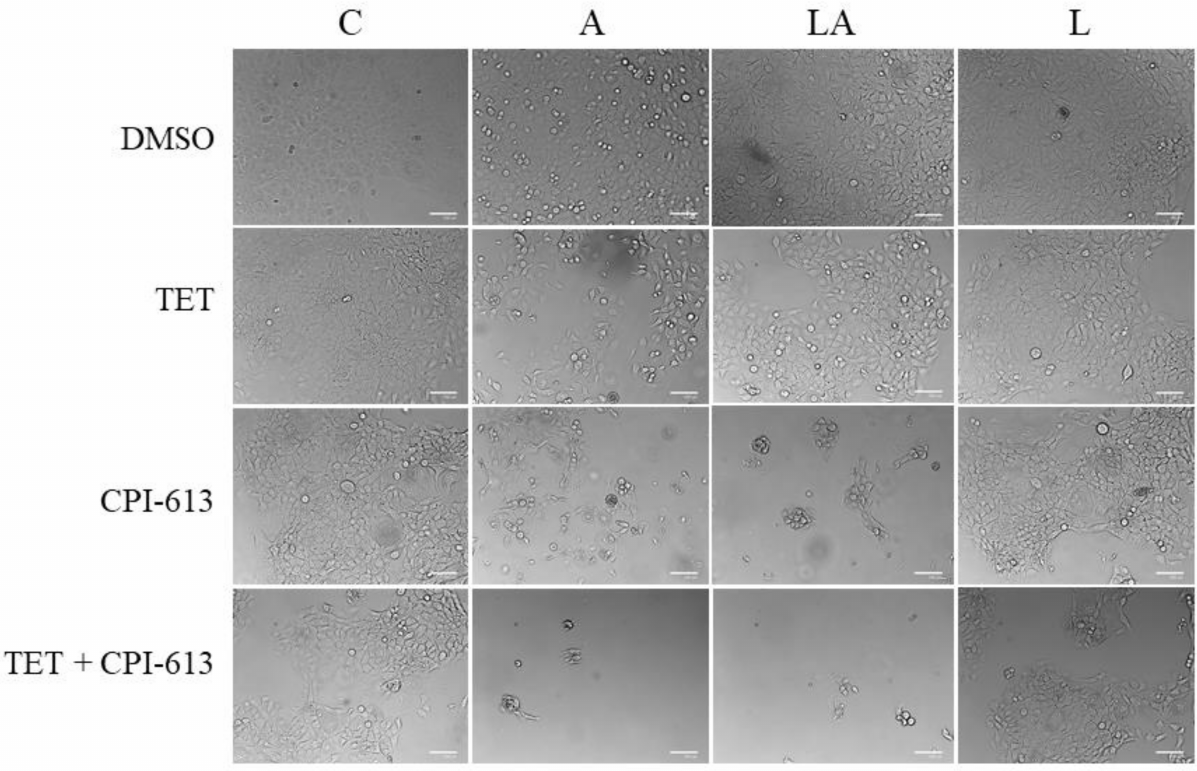
Figure A8. Representative images of 2D cultures treated with CPI-613 and tetracycline for 2 weeks. PaTu-8902 cells were cultured for 2 weeks in the presence of 1% dimethyl sulfoxide as a vehicle (DMSO), 50 µ M tetracycline (TET), 50 µ M CPI-613, or both.